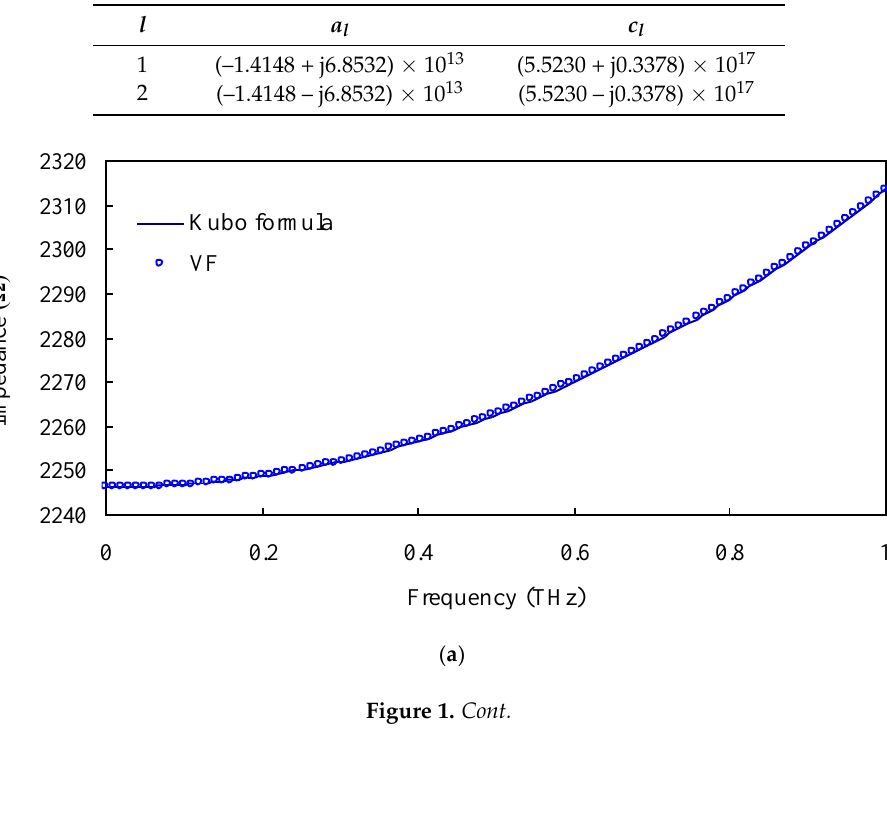
Table 1. The poles a l and residues c l when p = 2.